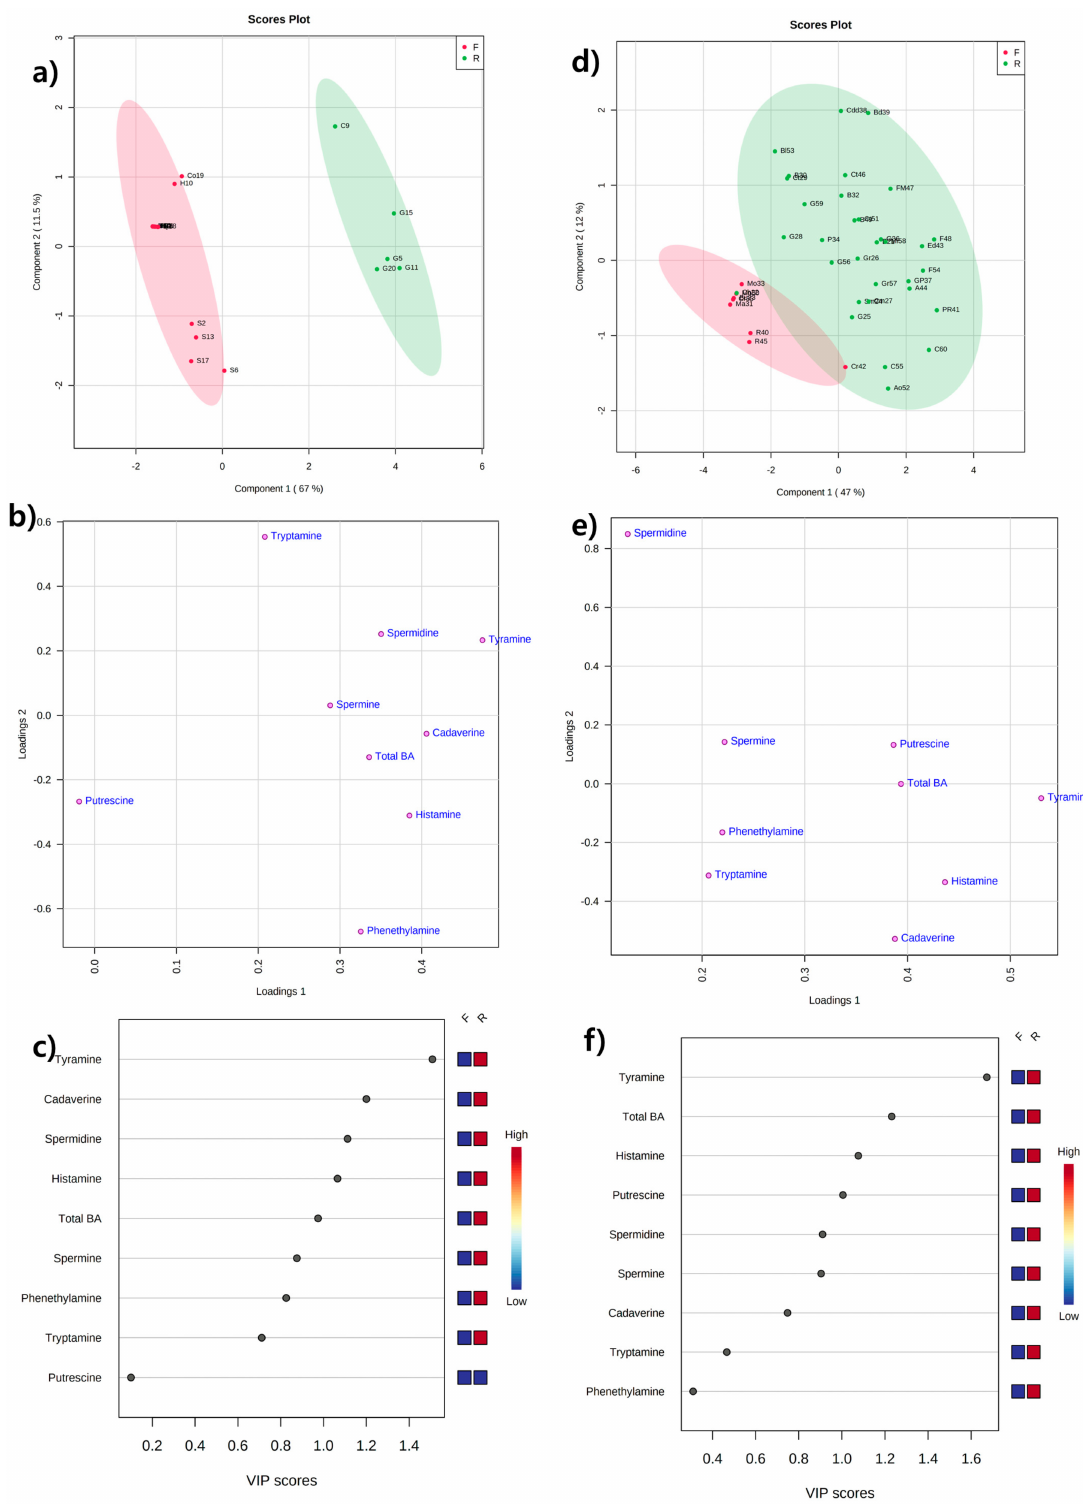
Figure 4. Partial least-squares discriminant analysis (PLS-DA) score ( a , d ), loading ( b , e ) and VIP plots ( c , f ) derived from the biogenic amine profiles demonstrating the separation between the fresh and ripened cheese samples from the farmstead (left) and retail markets (right) in the Republic of